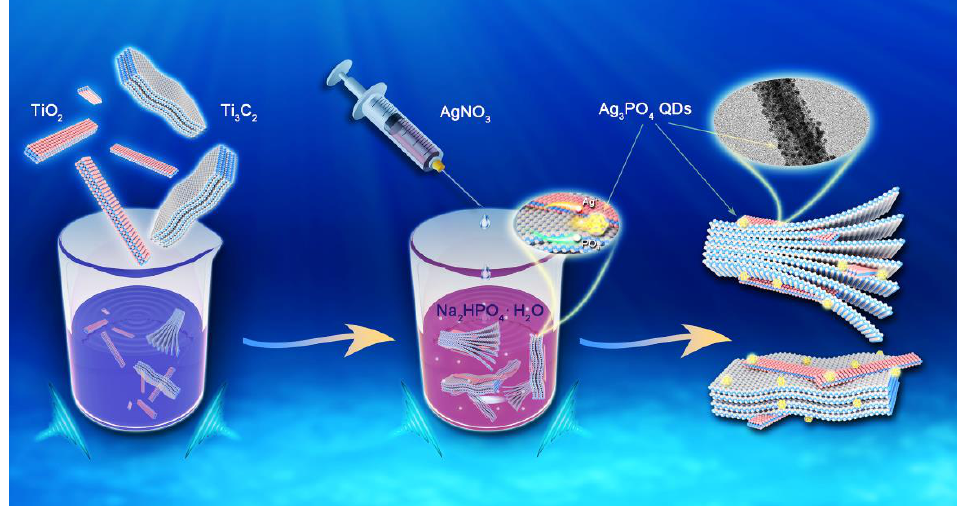
Figure 6. Preparation flow chart of TiO 2 (B)/Ti 3 C 2 MXene/Ag 3 PO 4 ternary